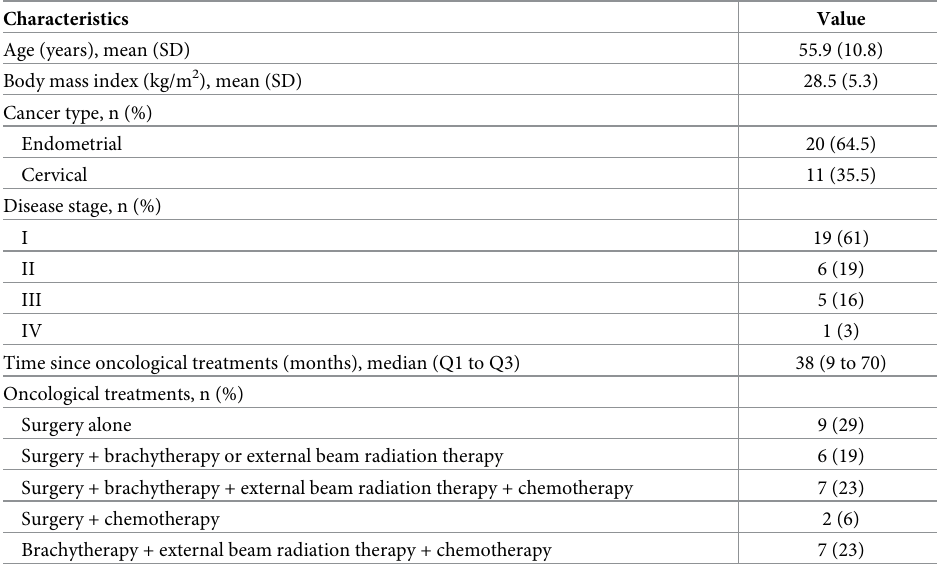
Table 1. Sample characteristics at